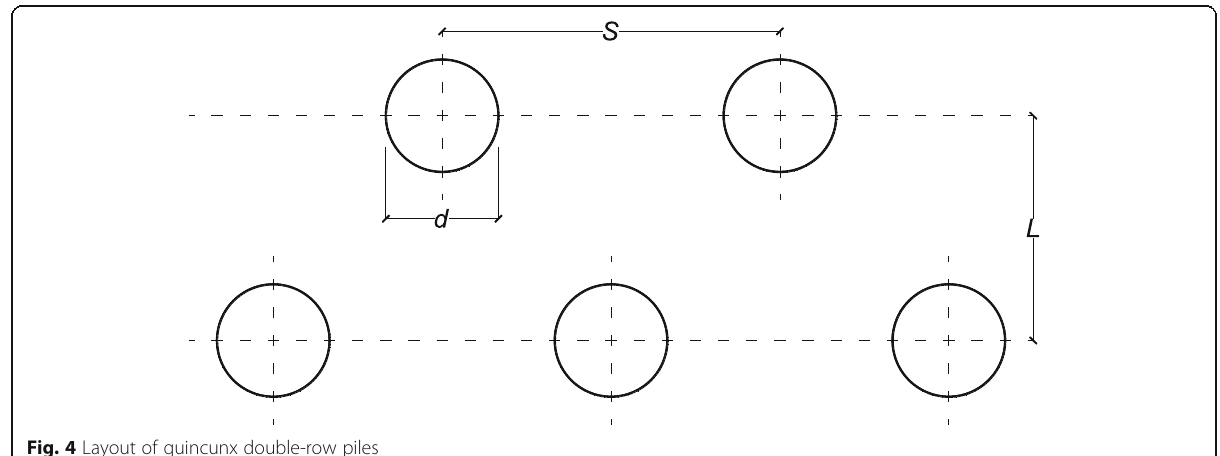
Fig. 4 Layout of quincunx double-row